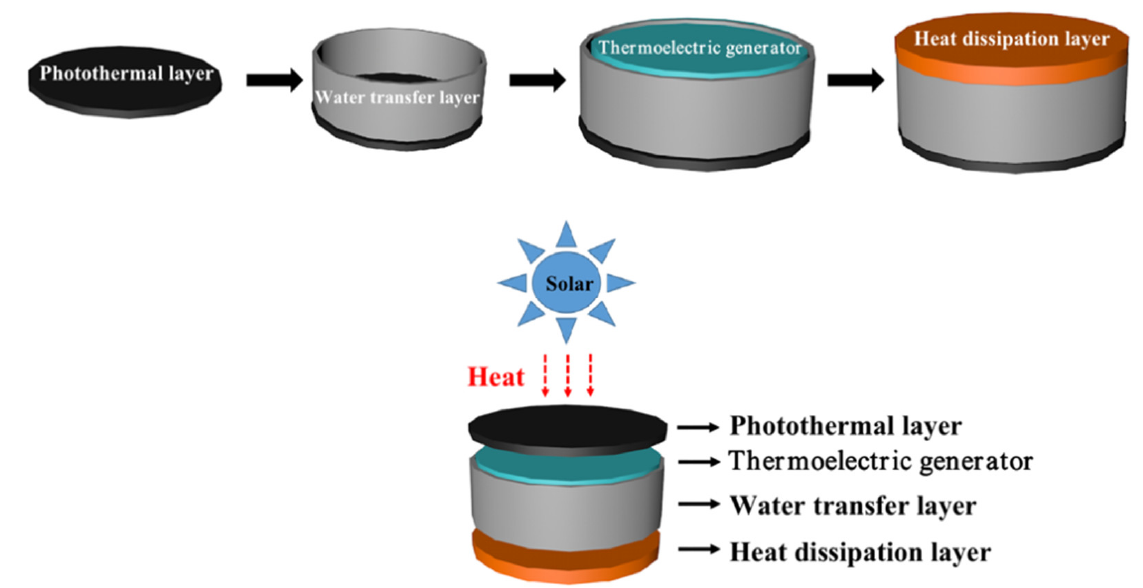
Figure 1. Schematic diagram of the composition of the integrated photo-thermal-electric conversion device.